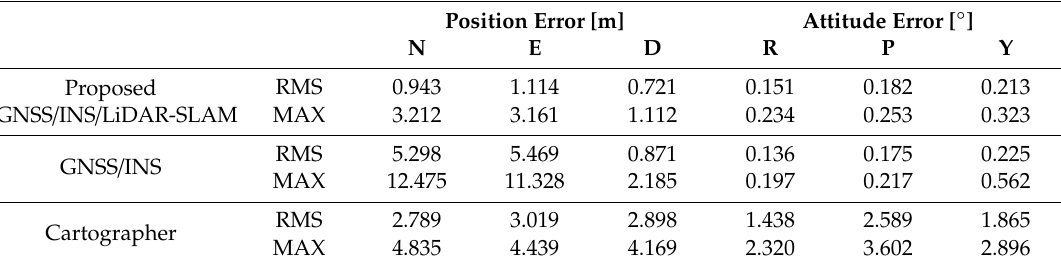
Figure 11. Position and attitude errors of Cartographer in the GNSS outage simulation test #2. Table 2. Errors statistics for the GNSS outage simulation tests. T able 2 Errors statistics for the GNSS outage simulation tests.